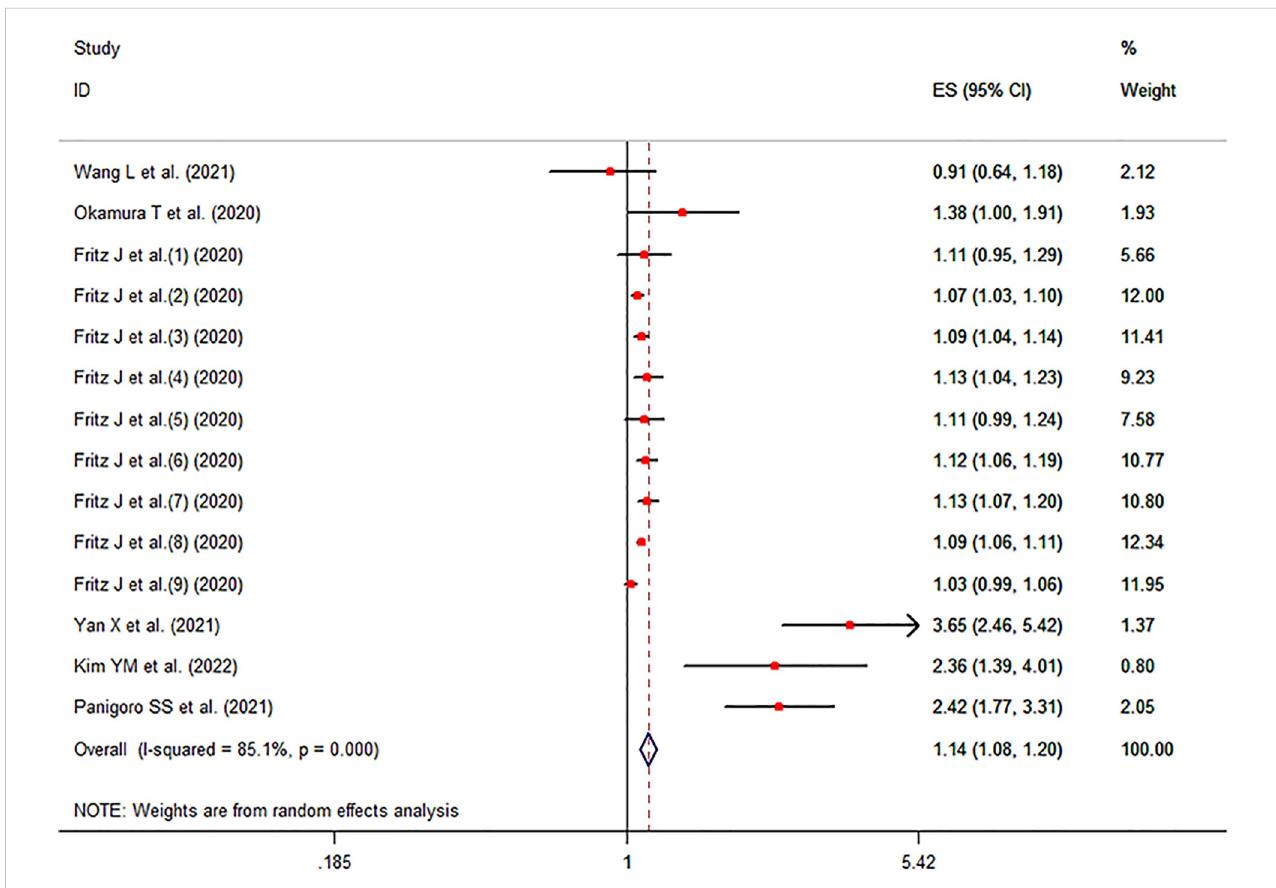
FIGURE 2 Forest plot of the cancer risk in subjects with high TyG index vs. control